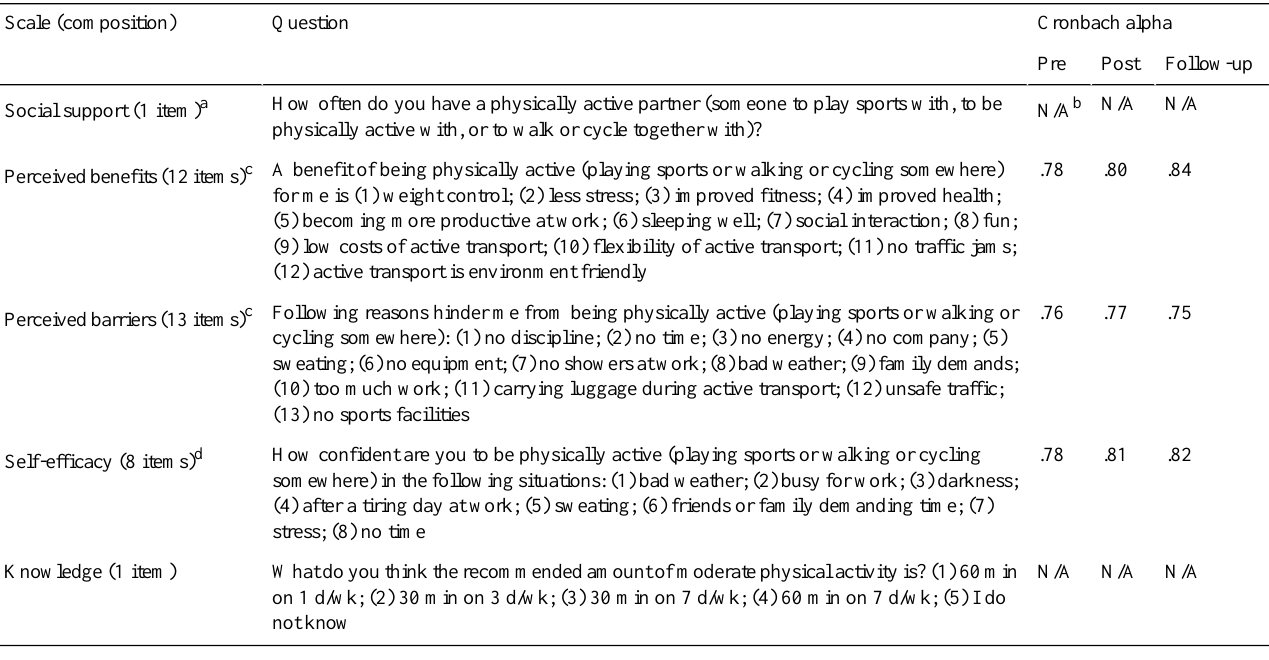
Table 1. Summary of psychosocial measures and Cronbach alpha values.